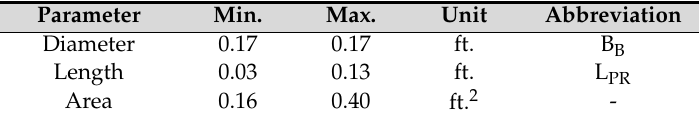
Table 7. The bulbous pier geometric characteristics.